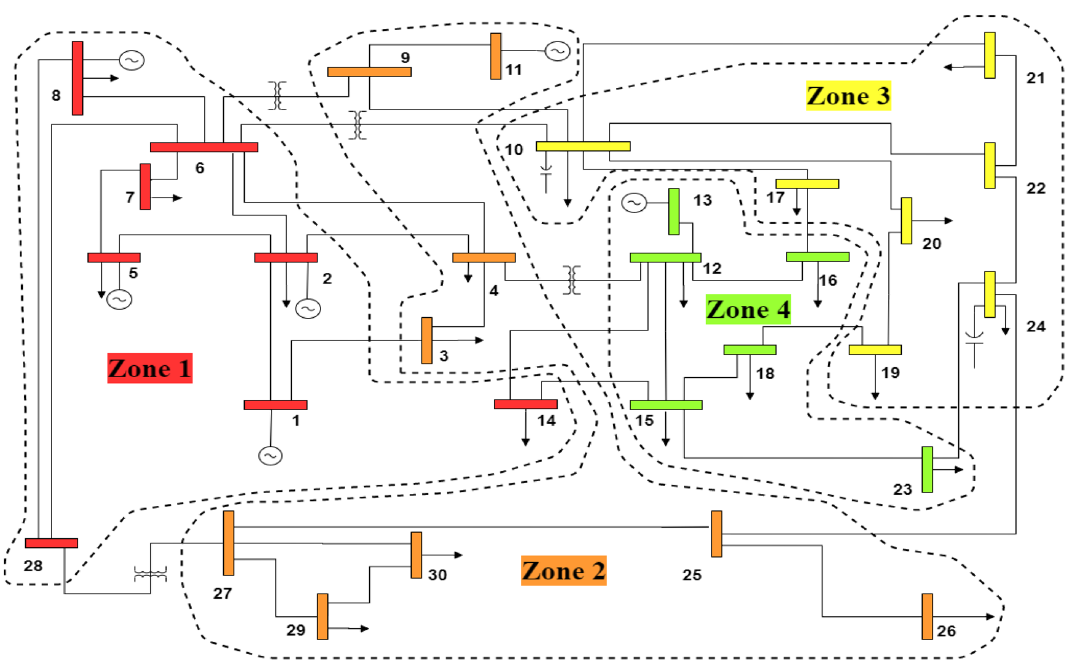
Fig. 2 Clusters/Zones for congested line 4–6